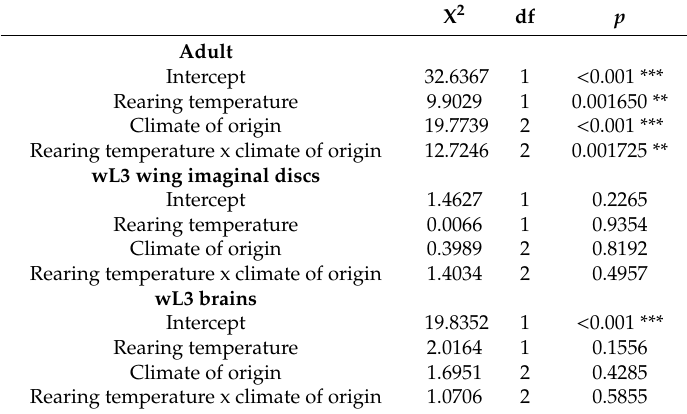
Table 2. Analysis of variance for e ff ects of rearing temperature and climate of origin on vg expression. X 2 df p Adult Intercept 32.6367 1 < 0.001 *** Rearing temperature 9.9029 1 Rearing temperature x climate of origin